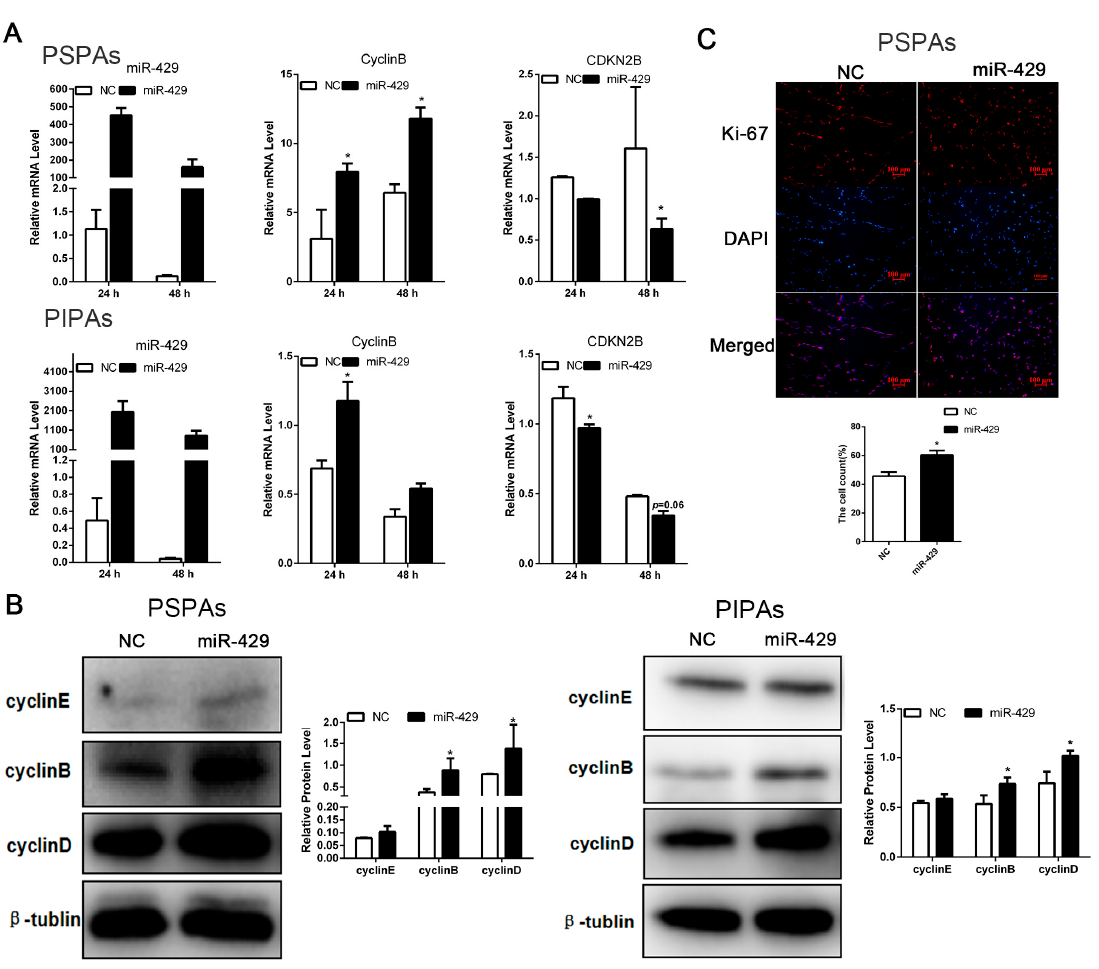
Figure 5. The enhanced miR-429 level upregulated the expression of proliferative marker genes. ( A ) The mRNA expression of miR-429, Cyclin-B and CDKN2B were detected at 24 and 48 h after transfection in PSPAs and PIPAs ; ( B ) Relative protein level of Cyclin E, Cyclin B and Cyclin D were detected by Western Blotting for 48 h of transfection in PSPAs and PIPAs ; ( C ) After transfection with miR-429 agomir/NC at 48 h, PSPAs was stained for Ki-67 immunofluorescent staining (bar size = 100 µm). Results are indicated as means ± SEM; n = 3; * p < 0.05.